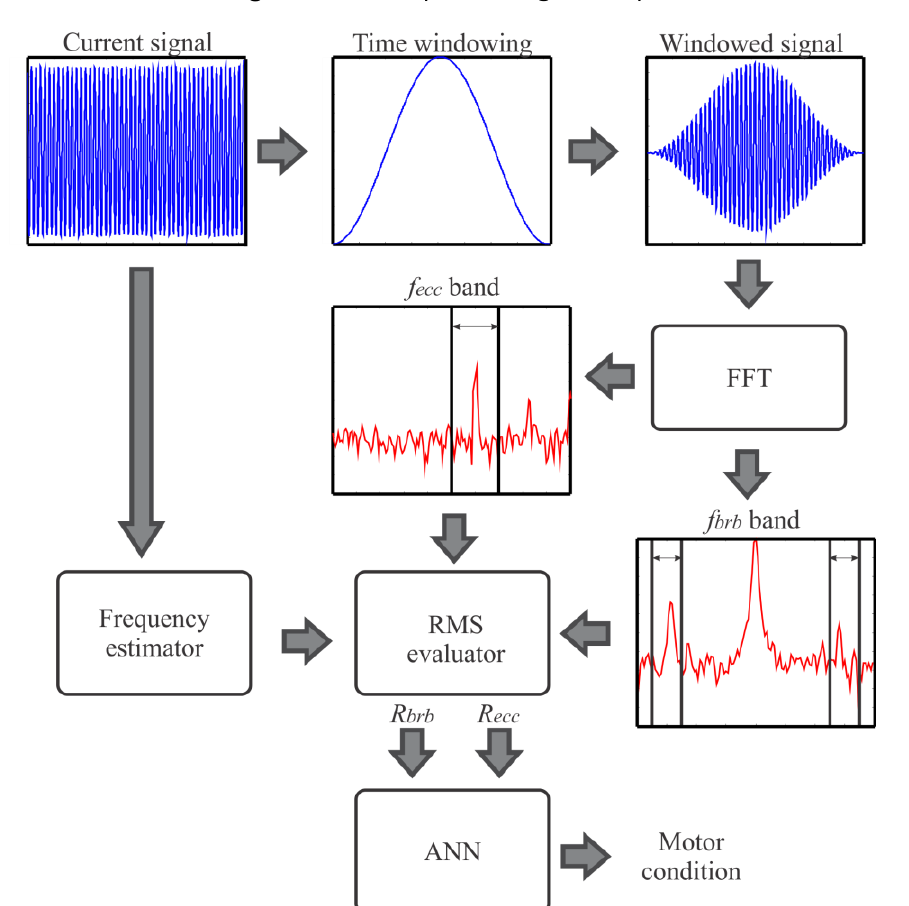
Figure 6. Smart processing flow